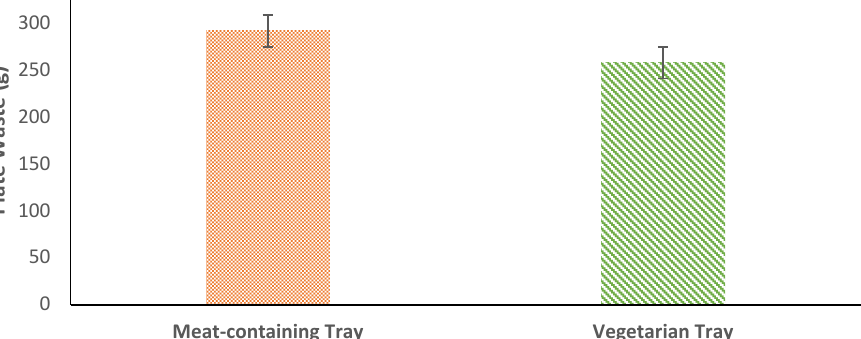
Figure 2. Plate waste from meat-containing and vegetarian meals. Vegetarian meals had less FW than meat-containing meals. Error bars represent the standard error of mean.